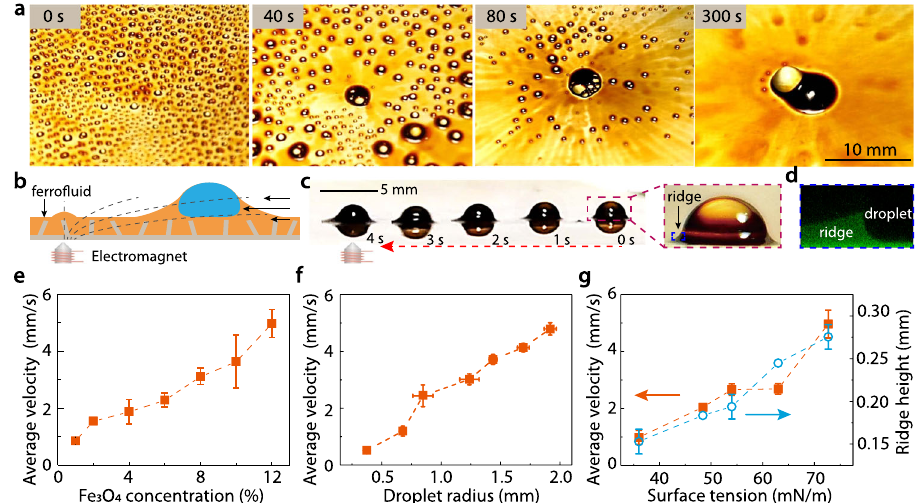
Fig. 1 Magnetic actuation of additive-free droplets on ferro fl uid-infused slippery surface. a Collective actuation of numerous micro-sized droplets. The growing black part at the center was the ferro fl uid (12 v/v% Fe 3 O 4 nanoparticles) raised by the electromagnet. b The actuation force is provided by the ferromagnetic wetting ridge that spontaneously forms around the deposited droplet. The dotted lines and the solid arrows illustrate the magnetic induction lines and the droplet moving direction, respectively. c Snapshots of a typical actuation process. Red dotted arrow indicates the droplet moving direction. Inset: magni fi ed optical image of the deposited droplet (rose red dashed rectangle), showing the wetting ridge (blue dashed rectangle). d Confocal fl uorescence image of the wetting ridge. e The driving velocity increases with the concentration of the magnetic particles (Fe 3 O 4 nanoparticles) in the ferro fl uid (drop volume: 2 µ L). f The velocity also increases with the droplet radius for different liquids, presumably because the ridge volume increases with the droplet size, and g it increases with the surface tension of the droplet (orange solid squares), presumably because a liquid with higher surface tension generally raises higher ridge (blue open squares). Dashed lines are eye-guide. The error bars represent the standard deviation ( n =